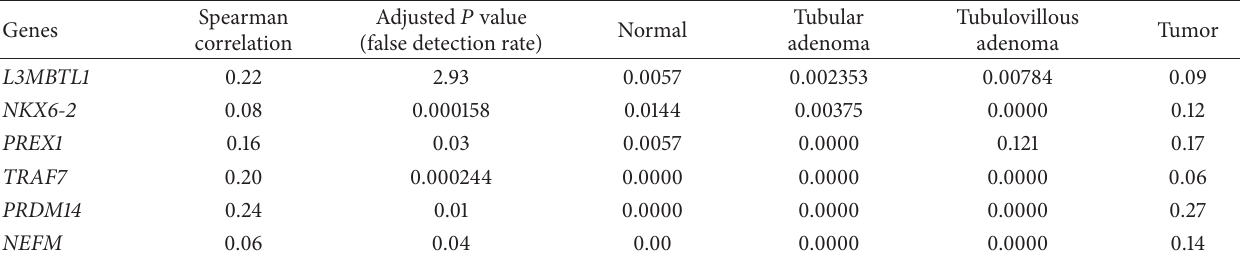
Table 2: Identified hypermethylated genes in colon neoplasia